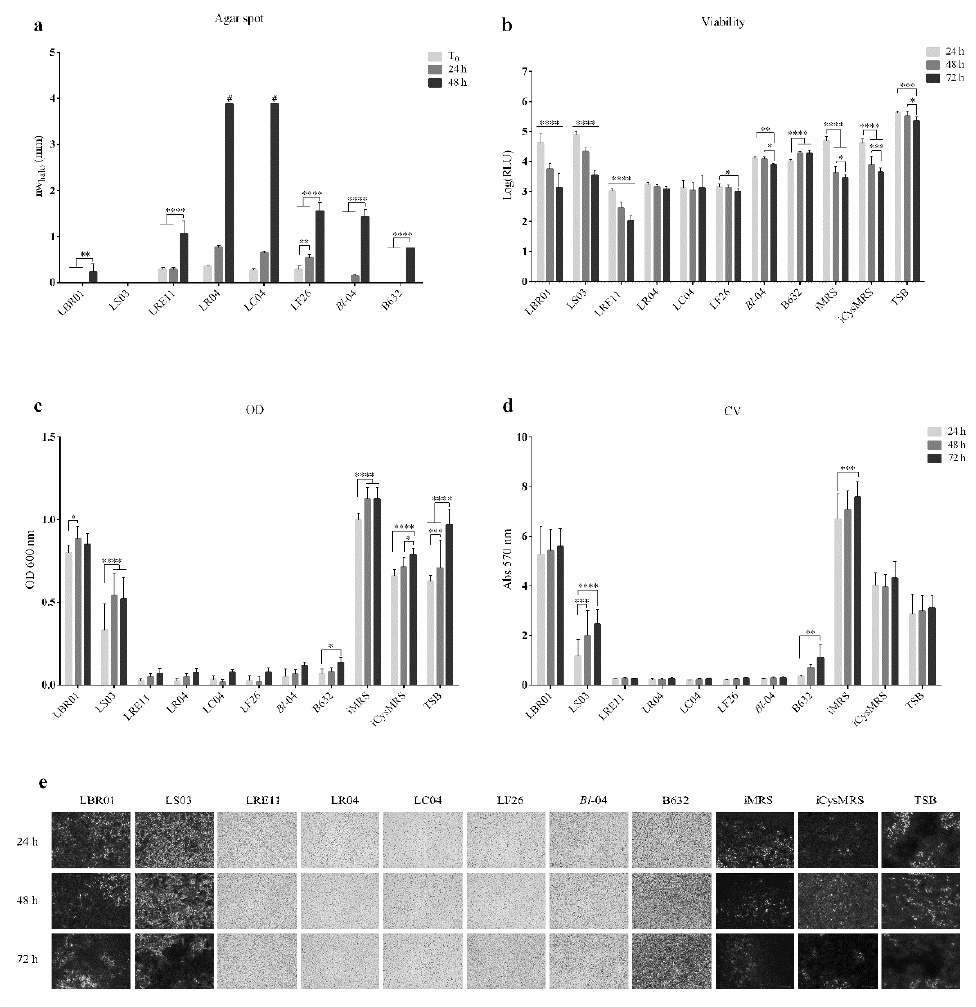
Figure 5. Live probiotic and CFS efficacy on a complex bacterial environment. ( a ) Normalized width measurements of inhibition halos obtained in the complex agar spot test. The diameters in mm of the inhibition halos were measured after 48 h of the three-pathogen incubation with the probiotic spots without (T 0 ), or with 24 and 48 h pre-incubation. In the graph, the normalized width halo (nw halo ) is expressed as the mean of three independent experiments ± SD. # complete growth inhibition zones. ** p < 0.01; **** p < 0.0001. ( b ) Viability assay. The pathogen-mix viability was determined after 24, 48, and 72 h of probiotic CFS treatment. Data are represented as the Log(mean) of three independent experiments ± SD. * p < 0.05; ** p < 0.01; *** p < 0.001; **** p < 0.0001. Log(RLU) = Logarithm10(relative luminescence unit); CFS = cell-free supernatant. ( c ) Optical density (OD) measurement at 600 nm and ( d ) Crystal violet (CV) biofilm quantification after CFS treatment of the complex pathogen environment. Data are represented as the mean of three independent experiments ± SD. * p < 0.05; ** p < 0.01; *** p < 0.001; **** p < 0.0001. OD 600 nm = optical density at 600 nm; Abs 570 nm = absorbance at 570 nm. ( e ) Representative CV-stained biofilm images obtained at FLoid TM Cell Imaging Station with magnification 460 ×